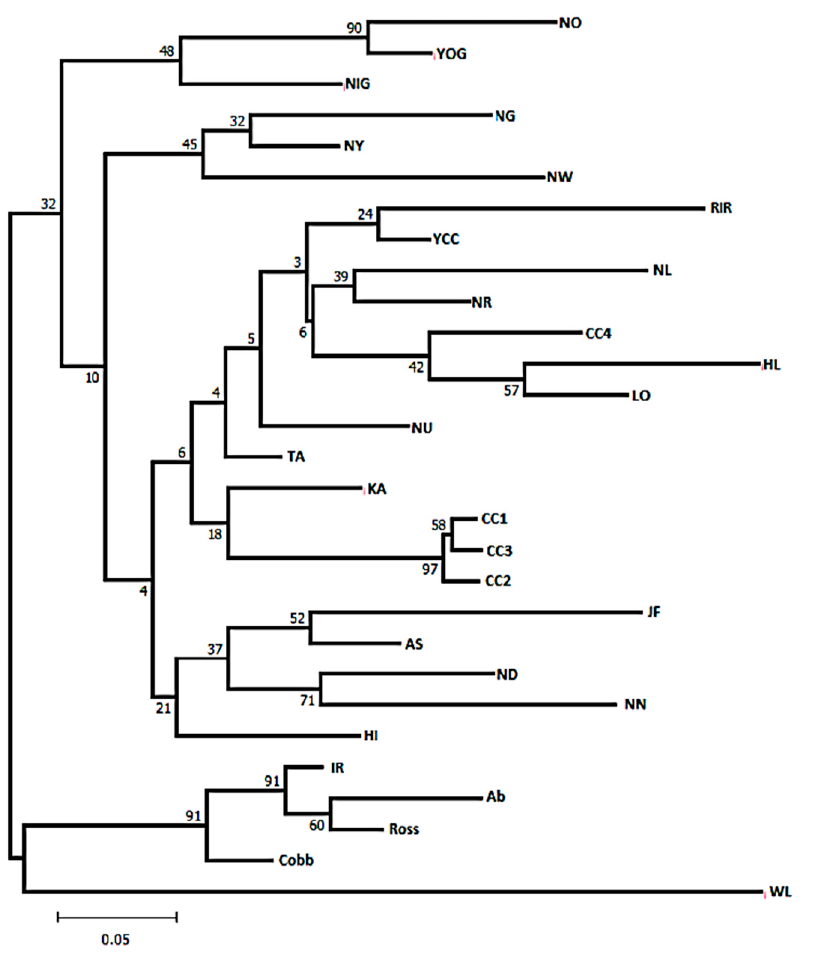
Figure 2. The Neighbour-joining tree of 29 populations constructed based on D A distance using Set 2 MHC- B microsatellite markers. The population abbreviations are defined in Supplementary Table S2.